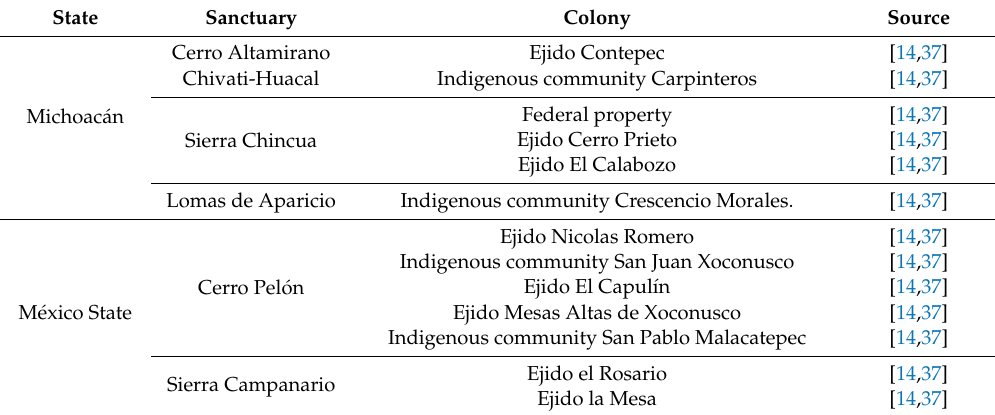
Figure 3. Historical trend of the area occupied by monarch butterflies (modified from Rendon-Salinas et al. [14] and Chefaoiu et al. [30]). Table 1. Reported sites for wintering of the monarch butterfly inside the Monarch Butterfly Biosphere Reserve